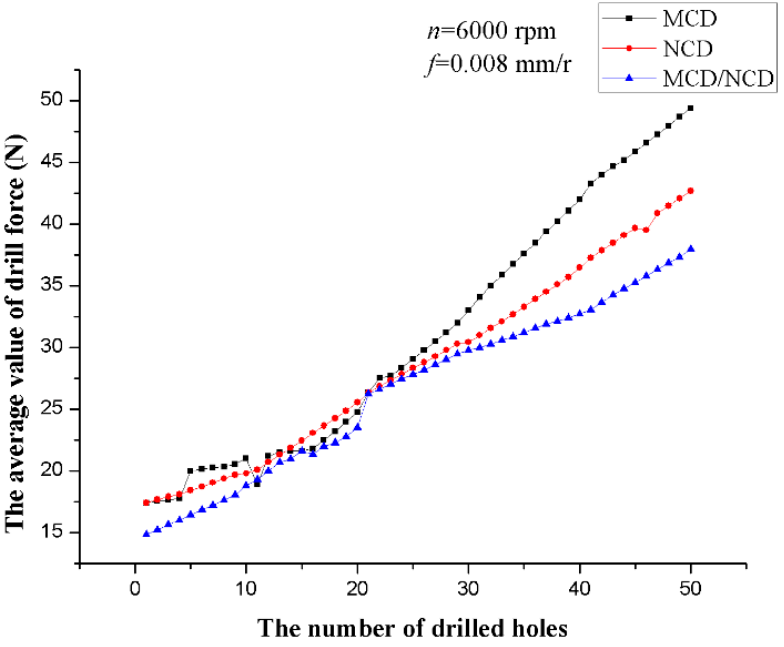
Figure 7. Force value versus the number of drilled holes under condition II.